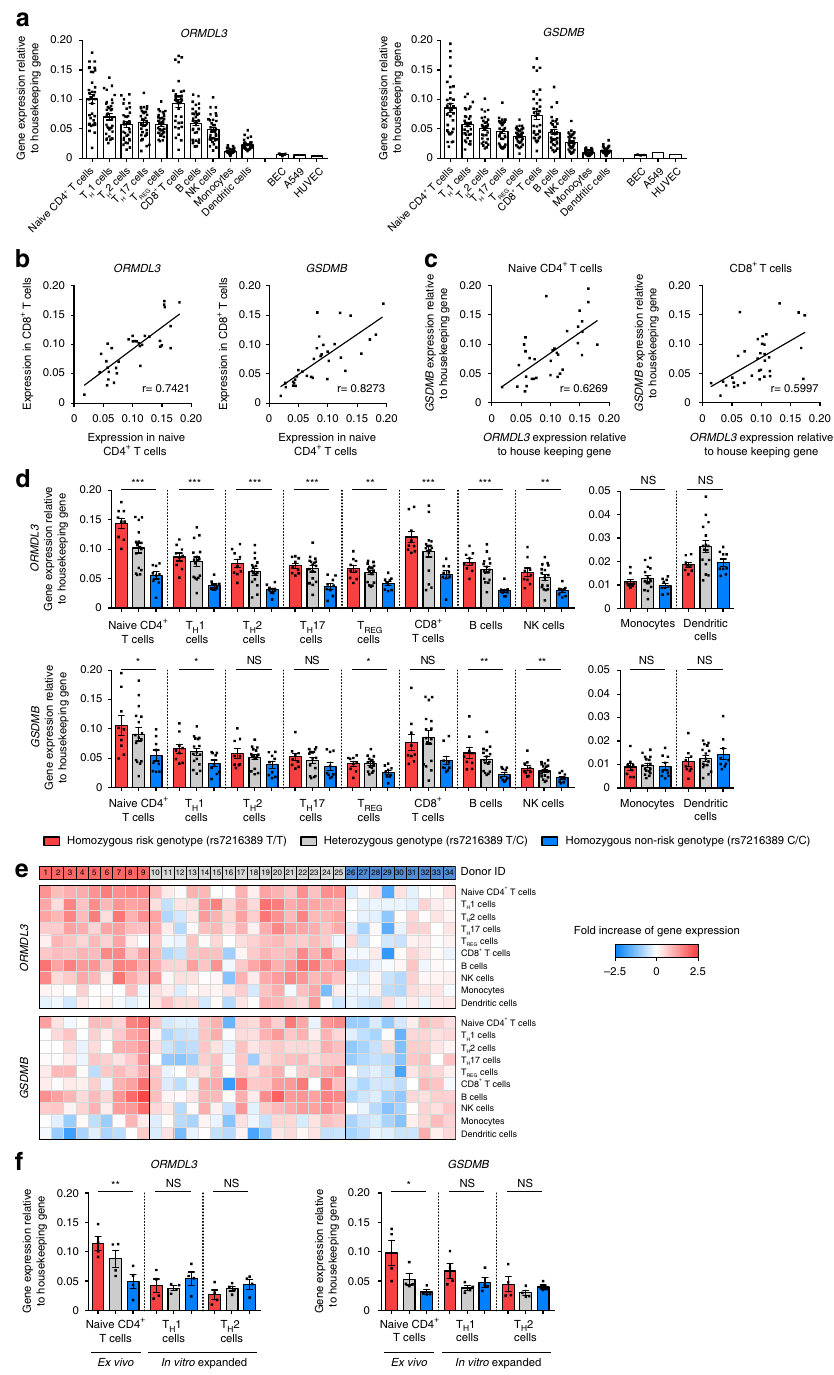
Figure 2 | 17q21 SNPs have pronounced effects on ORMDL3 expression in primary T and B cells. ( a ) Real-time PCR quantification of ORMDL3 and GSDMB transcript levels (relative to the housekeeping gene YWHAZ ) in the indicated primary immune cell types ( n ¼ 34 donors), bronchial epithelial cells (BEC; n ¼ 3), lung cancer cells (A549; n ¼ 1) and human umbilical vein endothelial cells (HUVEC; n ¼ 1). ( b ) Correlation of ORMDL3 and GSDMB transcript levels between naive CD4 þ T cells and CD8 þ T cells. ( c ) Correlation between ORMDL3 and GSDMB transcript levels in naive CD4 þ T cells and CD8 þ T cells. ( d ) ORMDL3 and GSDMB transcript levels in the indicated cell types from donors categorized based on the genotype for asthma-associated SNP rs7216389 (homozygous risk (T/T): n ¼ 9, red bar; heterozygous (T/C): n ¼ 16, grey bar; homozygous non-risk (C/C): n ¼ 9, blue bar). ( e ) Heat maps show Log2 fold change in transcript levels of ORMDL3 and GSDMB relative to the average expression levels seen in the corresponding cell types from donors with the non-risk (C/C) genotype; the donors are ordered based on genotype and the number indicates the unique ID (Supplementary Data set 3). ( f ) ORMDL3 and GSDMB transcript levels in naive CD4 þ T cells and in in vitro expanded and polarized T H 1 or T H 2 cells from matched donors (see Methods), categorized based on the genotype as in d . Each dot represents data from a single donor. Error bars are mean ± s.e.m.; * P o 0.05, ** P o 0.01, and *** P o 0.001 by Student’s unpaired two-tailed t -test; NS, not significant; r value indicates the Spearman correlation